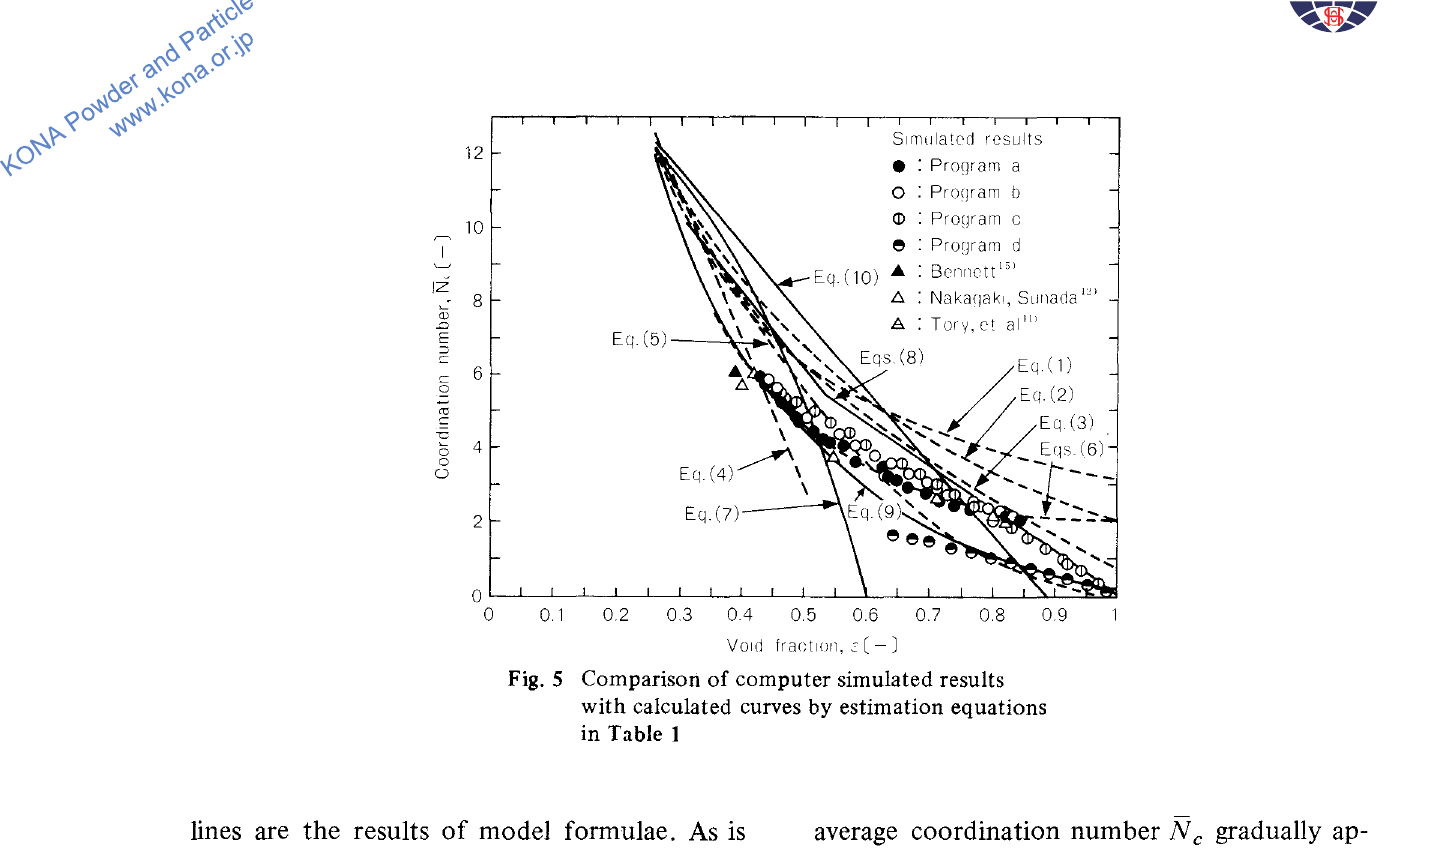
Fig. 5 Comparison of computer simulated results with calculated curves by estimation equations in Table